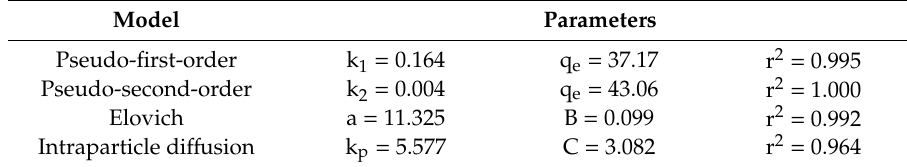
Table 3. Adjustment results of the experimental data to the four selected kinetic models.